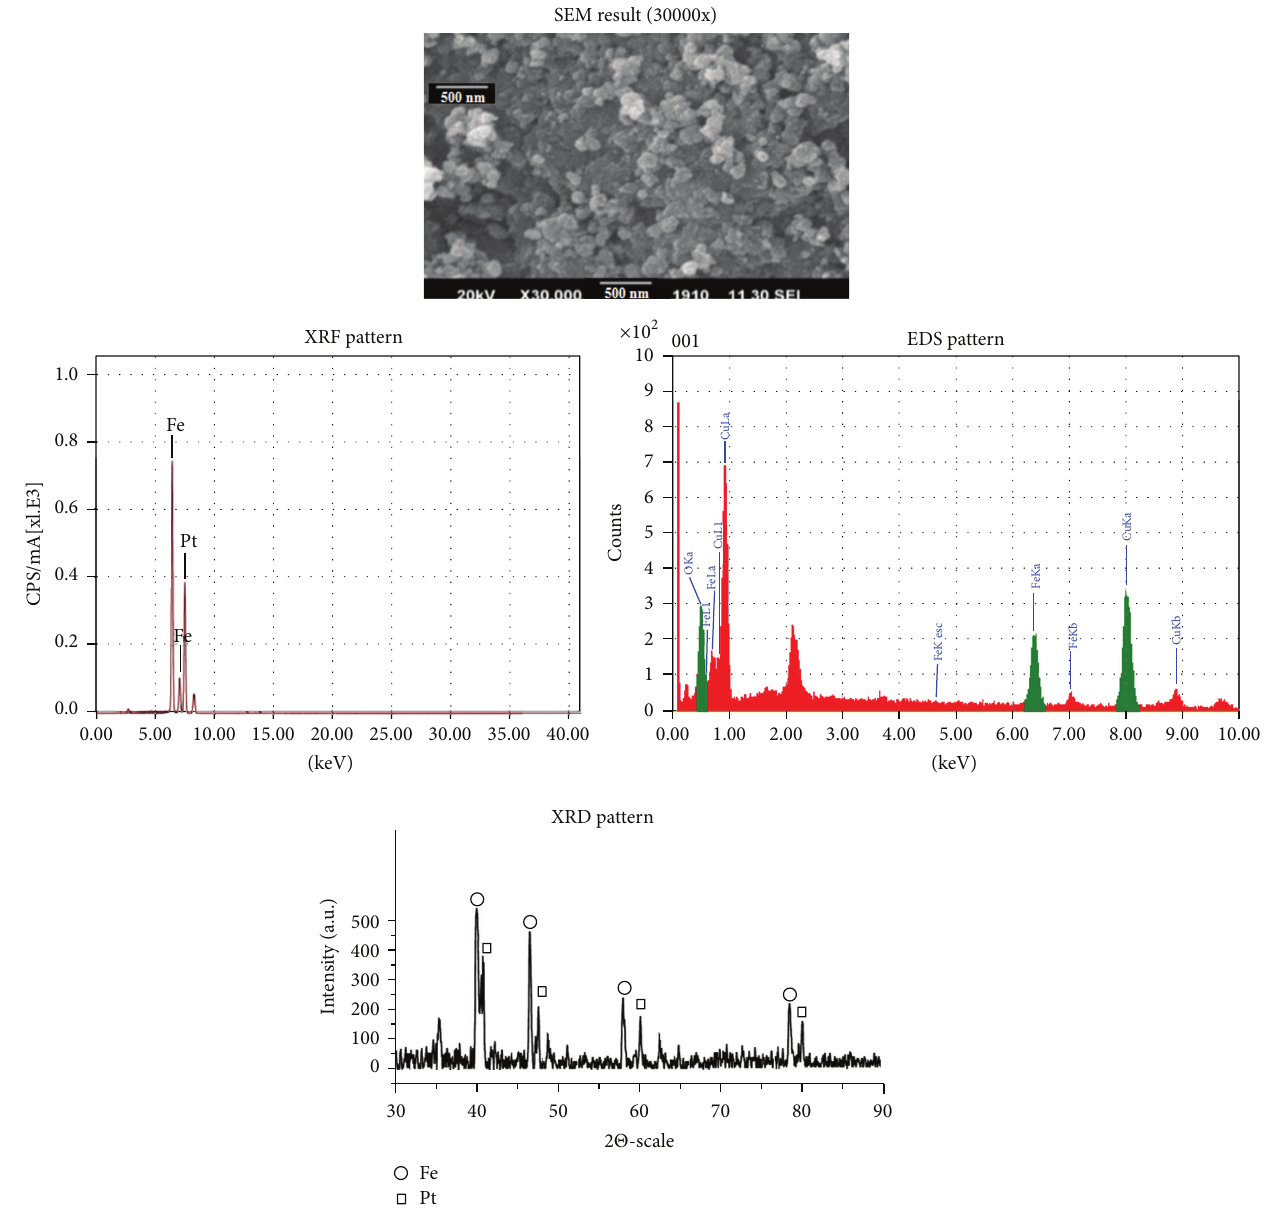
Figure 1: Characterization of Fe/Pt